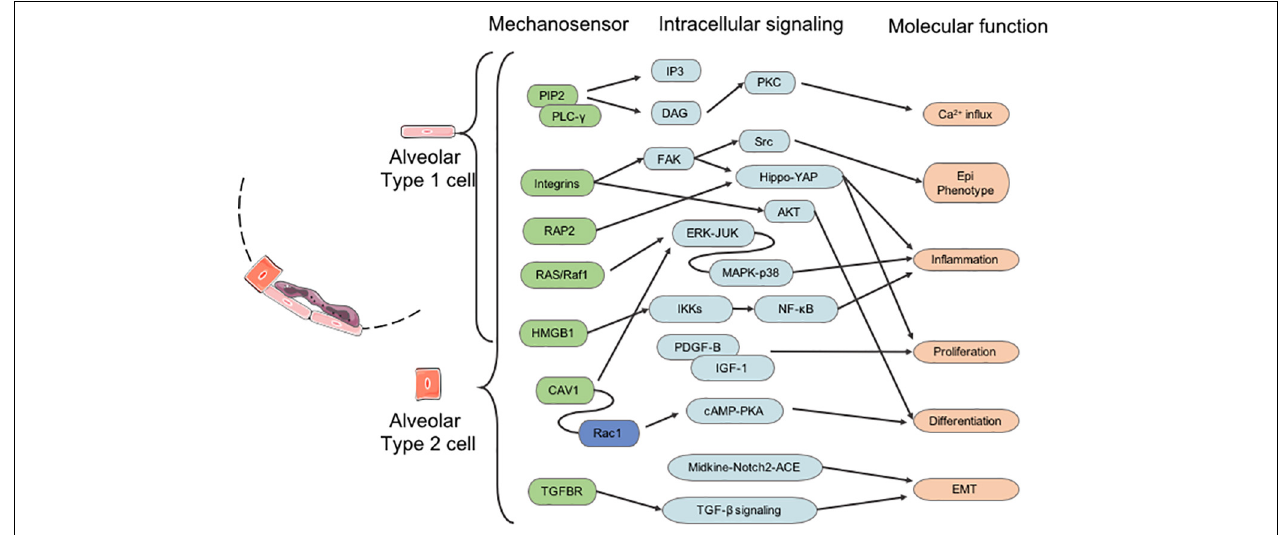
FIGURE 2 | The molecular signaling of mechanotransduction in alveolar type 1 and type 2 (AT1 and AT2) cells. EMT, epithelial-mesenchymal transition.